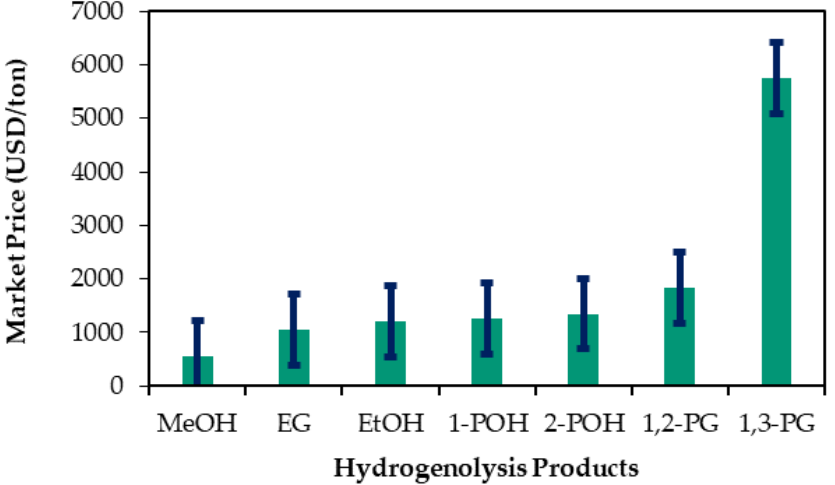
Figure 4. The market prices for the main products of glycerol hydrogenolysis.